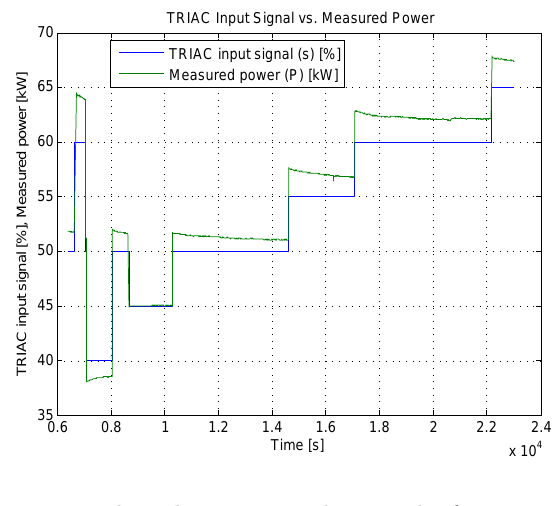
Figure 2: The dataset to be used for system